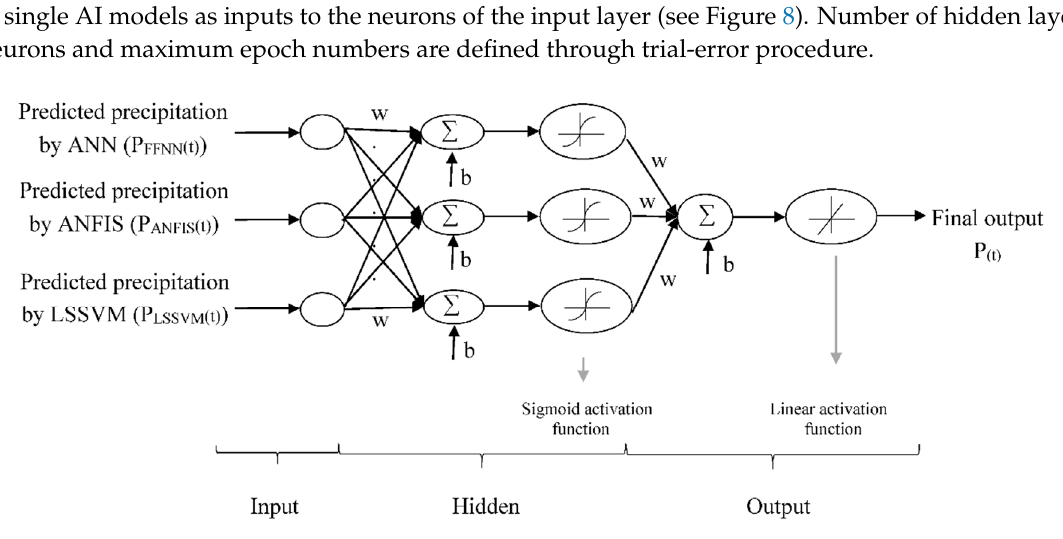
Figure 8. Schematic of the proposed neural ensemble method. ANN: artificial neural networks.